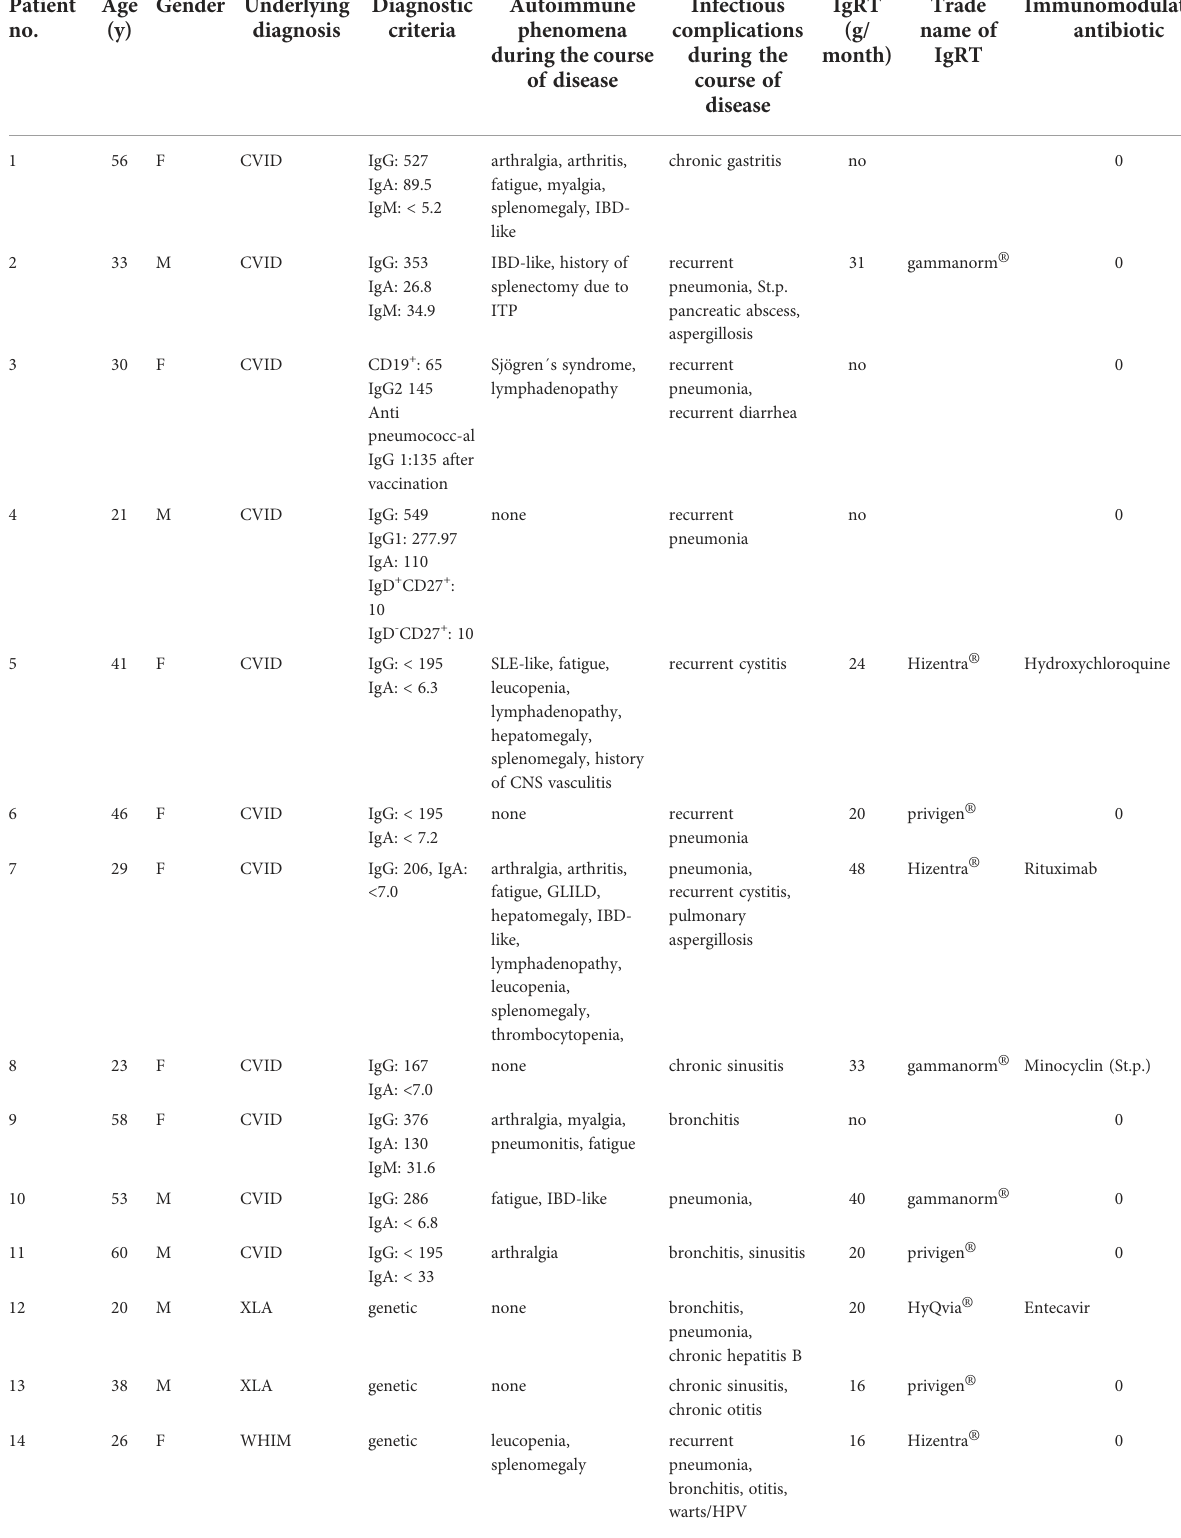
TABLE 1 Patient characteristics at baseline and autoimmune phenomena/infectious complications during the course of disease. Patient